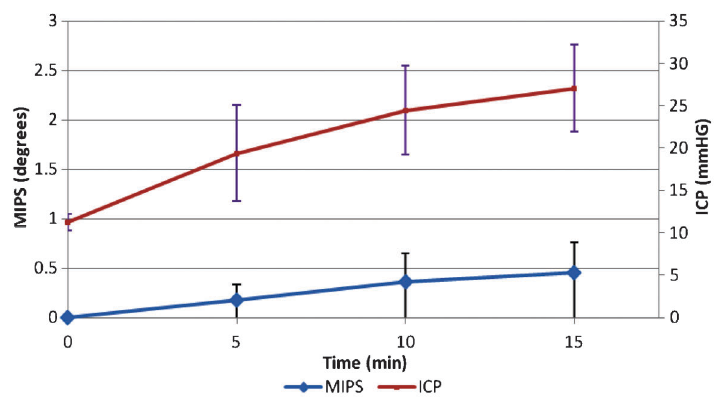
Figure 6. Average intracranial pressure (ICP) and magnetic induction phase shift (MIPS) of 6 rabbits with acute cerebral hemorrhage as a function of time after the surgical procedure. The total injection volume increased from 0 to 3 mL during the 15-min period.